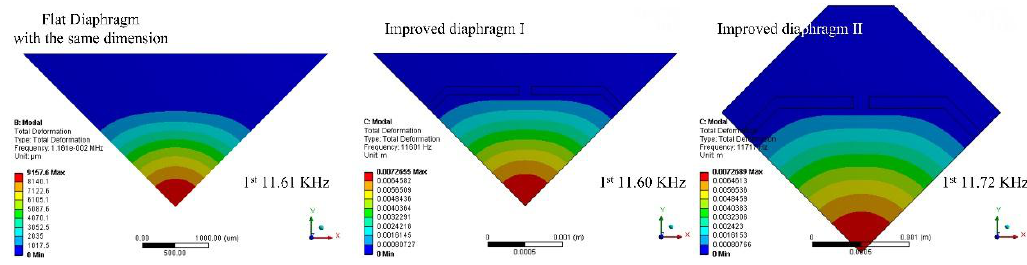
Figure 19. Dynamic behaviors of flat diaphragm, improved diaphragm I and improved diaphragm II.